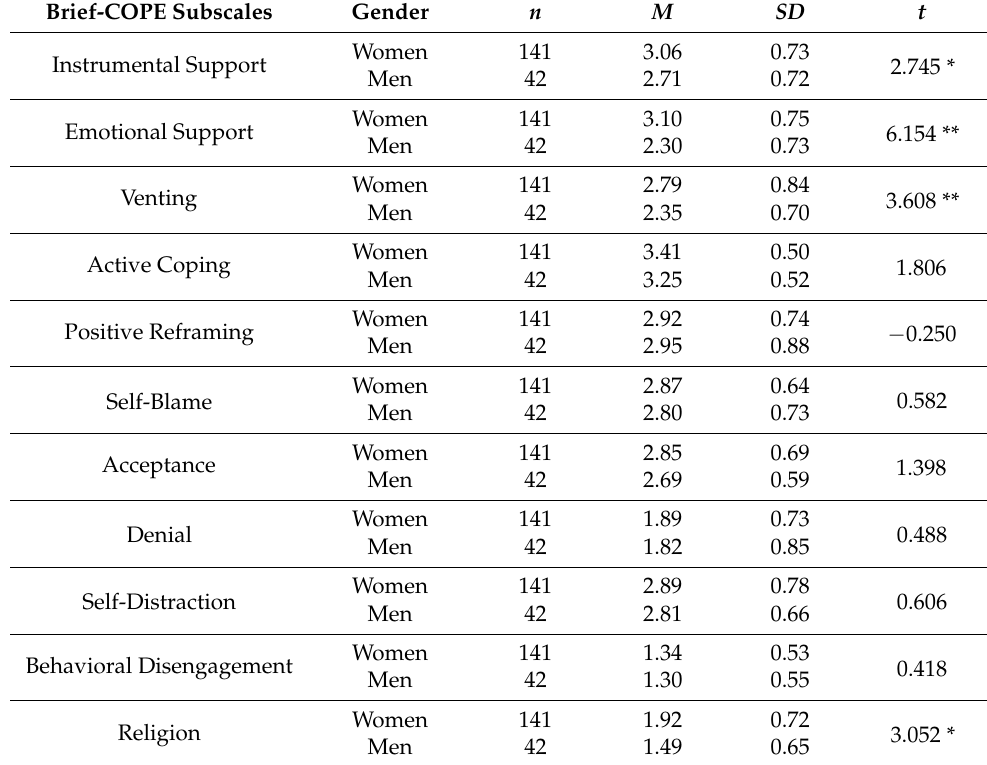
Table 2. Coping strategies by